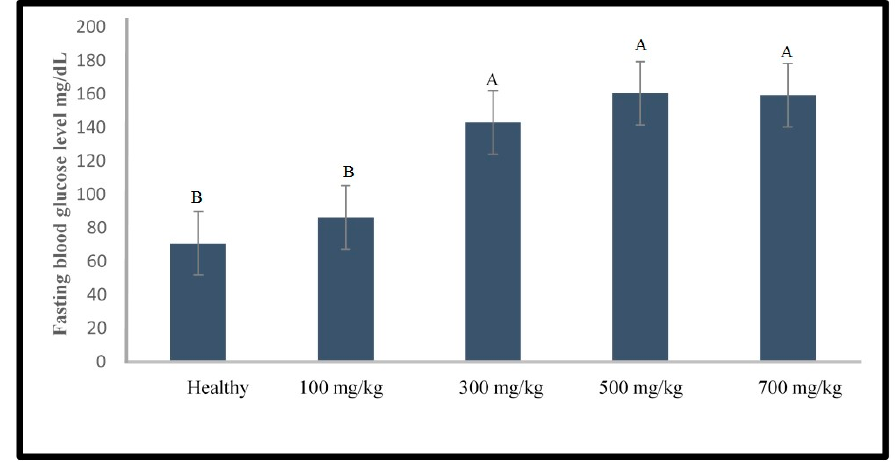
Figure 2. Fasting blood glucose level of zebrafish at 24 h analyzed after a single injection of STZ with various doses. Different capital letter indicates significant difference ( p < 0.05) among the values, n = 10.